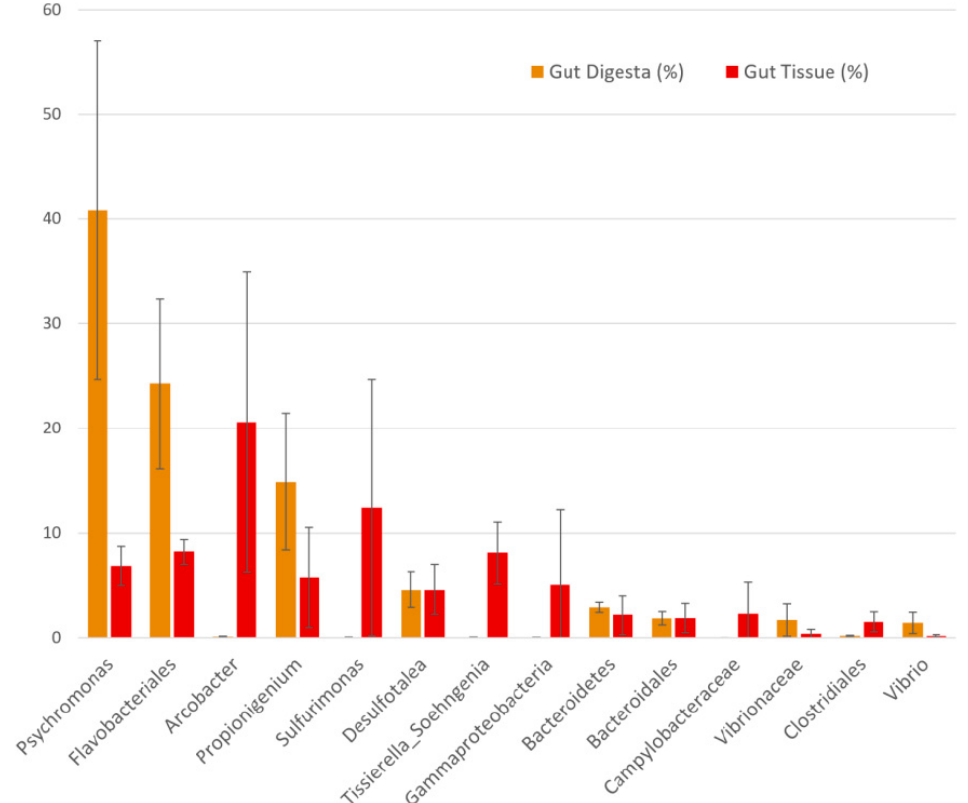
Figure 3. Comparison of the observed taxa between the gut tissue ( n = 3) and gut digesta ( n = 3) using the rarefied OTU table data. Taxa observed at <1% were filtered from the graph. Standard deviation and relative abundances were determined through STAMP (v2.1.3), and the graph was generated through Microsoft Excel Software (Seattle, WA, USA).